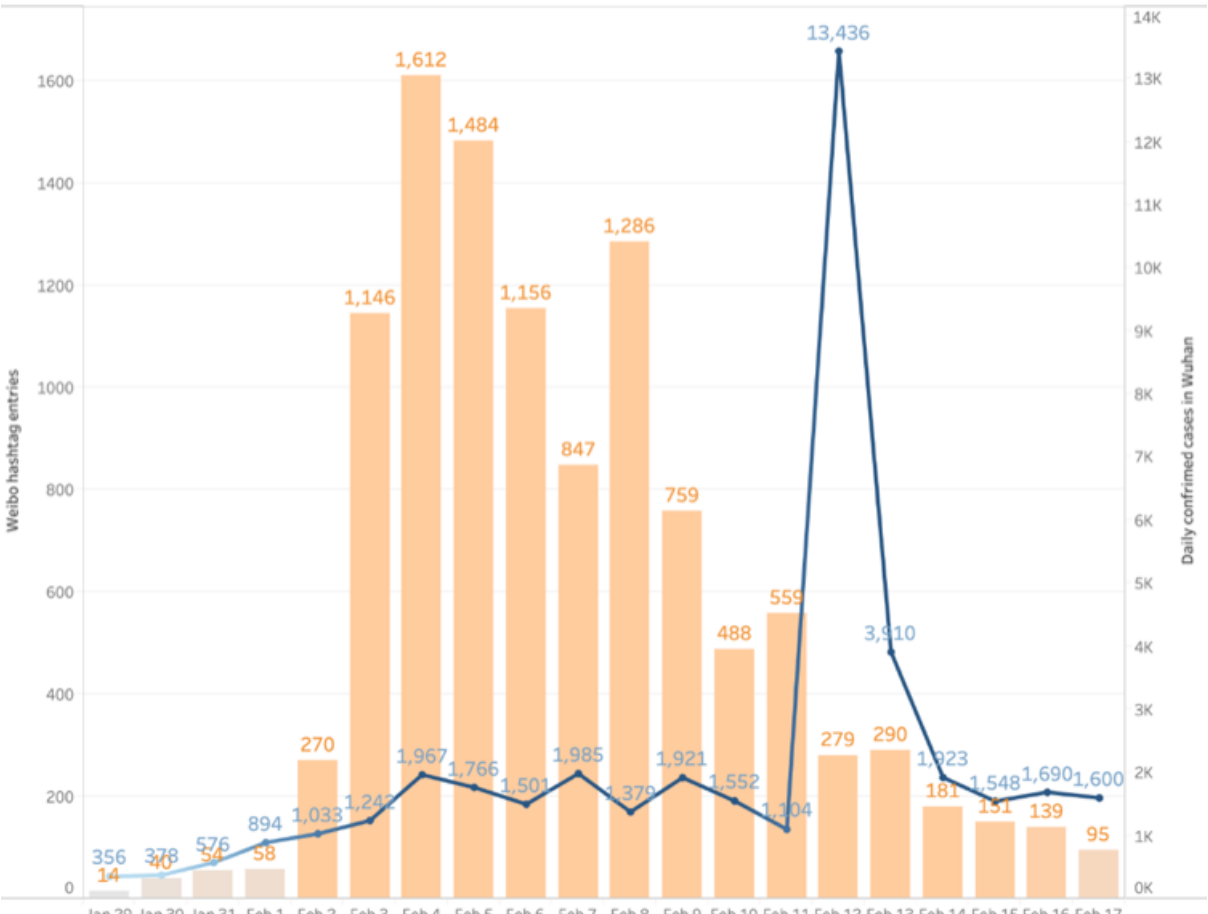
Figure 1. Daily numbers of #COVID-19 Patient Seeking Help hashtag entries (the orange bar plot) and daily confirmed cases in Wuhan (the blue line plot).